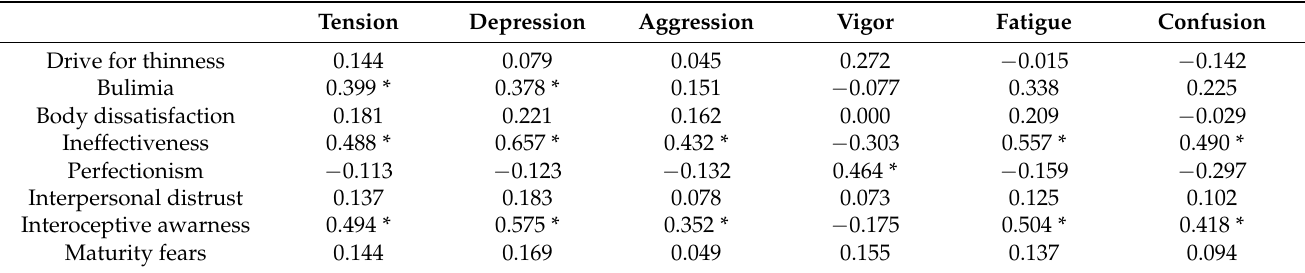
Table 3. Correlations between negative emotions and eating behavior among male (N = 62). Tension Depression Aggression Vigor Fatigue